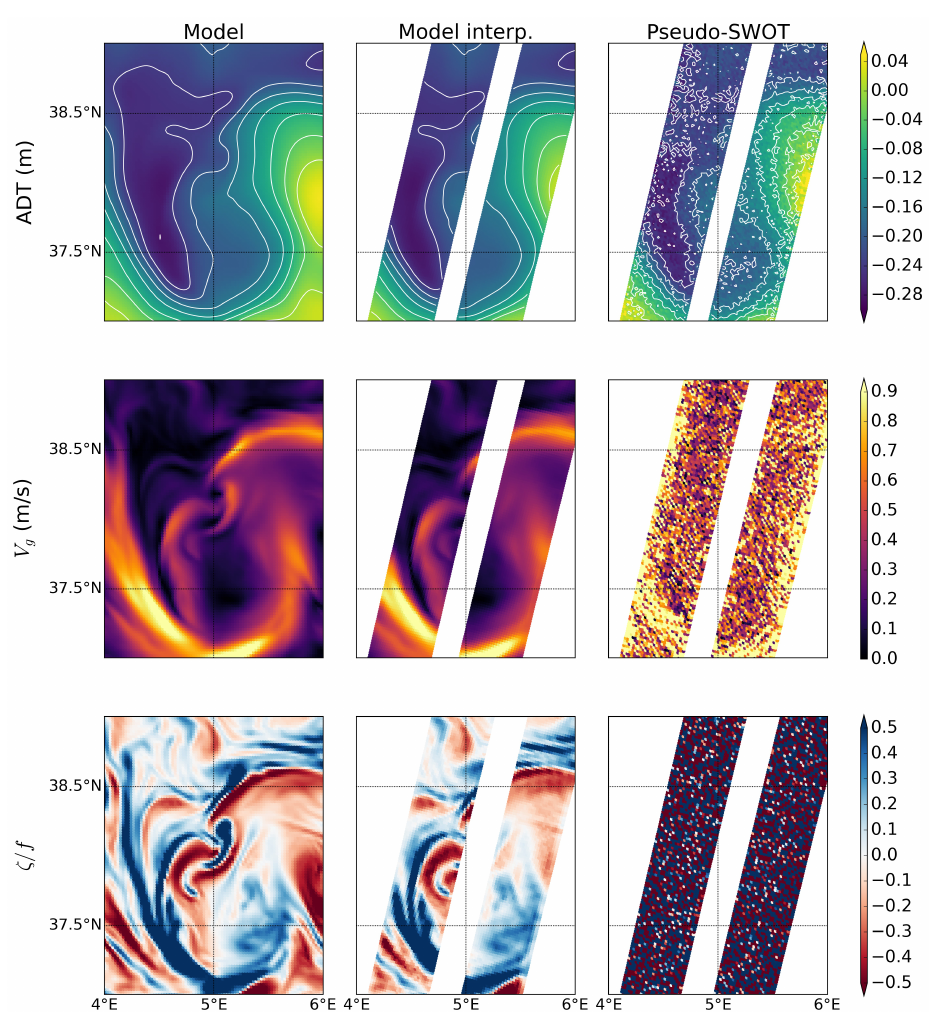
Figure 4. From top to bottom: SSH (m), geostrophic velocity (m/s) and relative vorticity ( ζ ) normalized by f, on 23 January 2009 corresponding to pass 15 of cycle 2 (box 1). The first, middle and last columns show the data obtained directly from the model (WMOP), from the model interpolated onto the SWOT grid (SSH model ), and with added noise (SSH obs ),